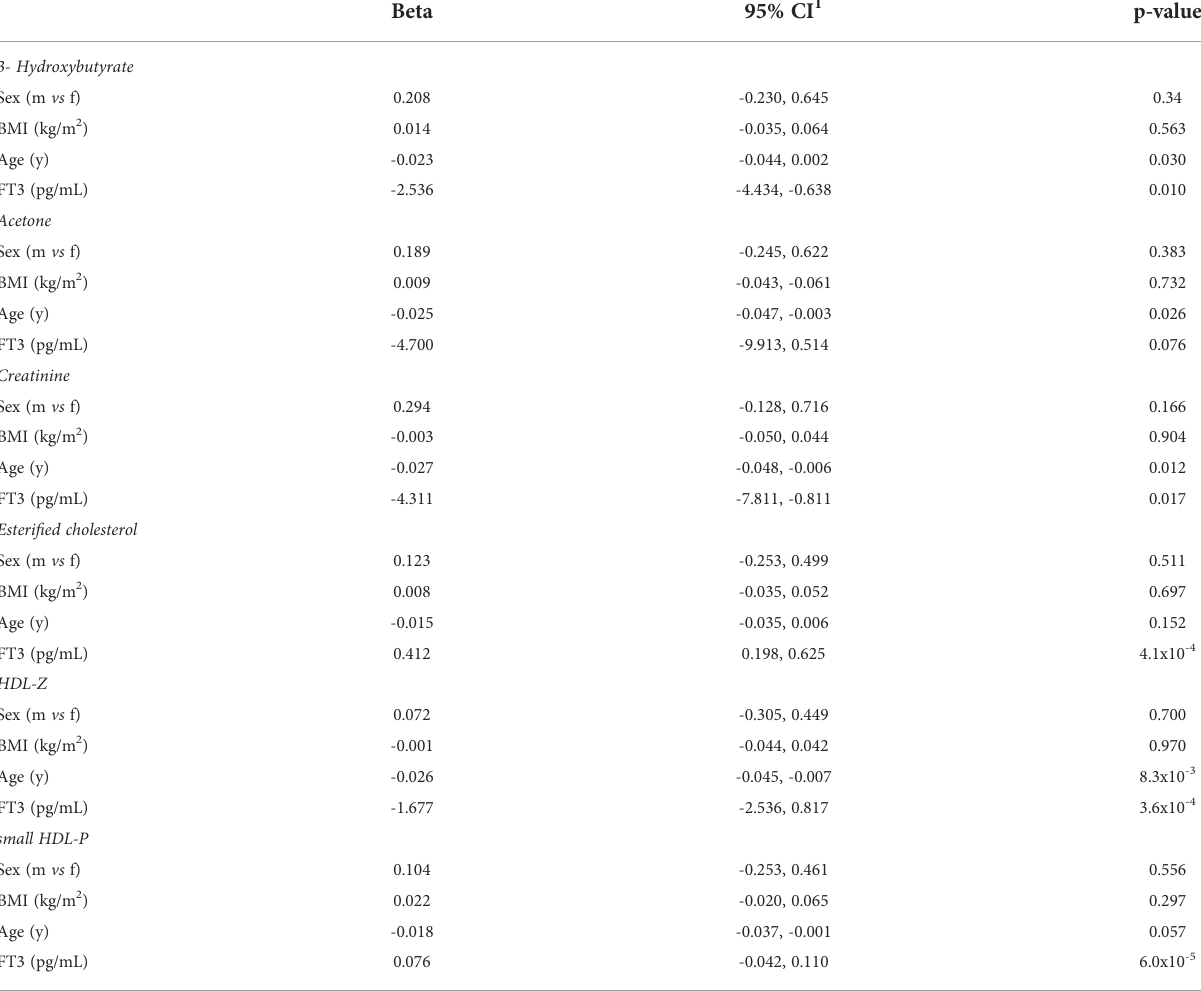
TABLE 8 Multivariate linear regression analysis of metabolomic variables according to FT3, with adjustment for age, sex and